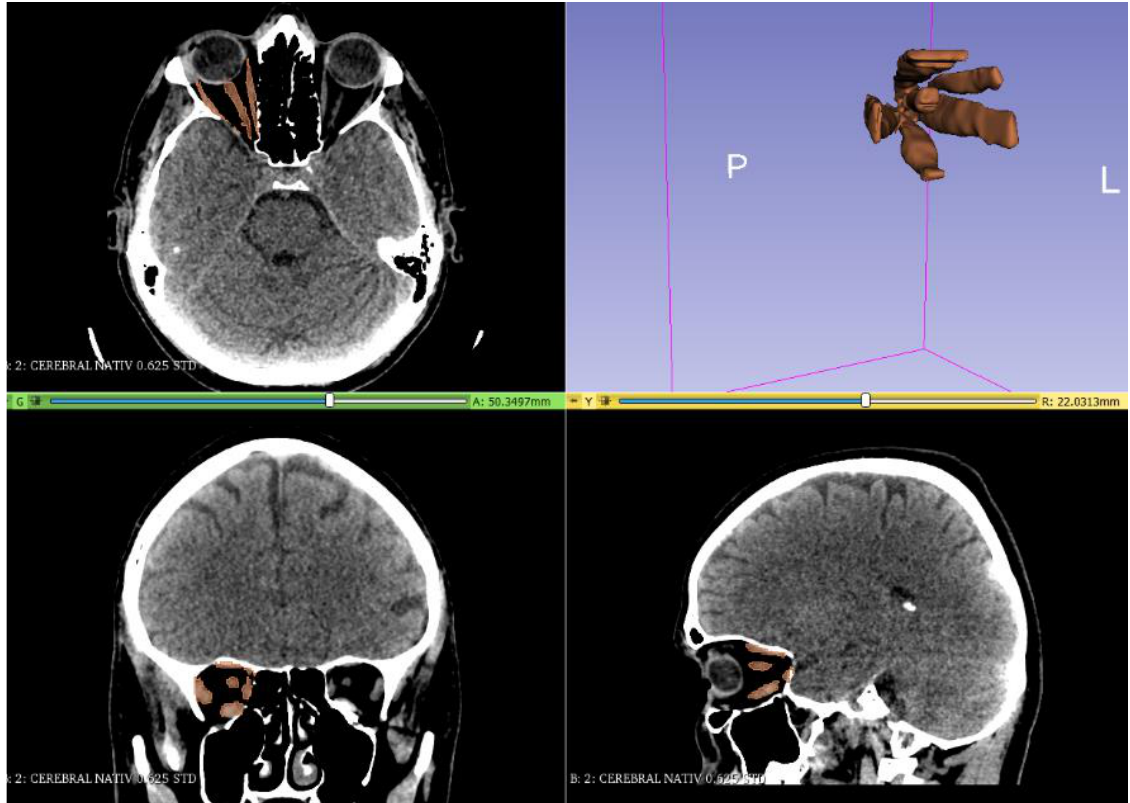
Figure 3. Segmentation of orbital muscles. Afterward, the 3D reconstructions were exported as STL (Standard Triangle Language/Standard Tessellation Language) files, and the Blender 3D Software was used for volume calculation. The values obtained were measured in cubic centime- ters (cm 3 ) (Figures 4–6).